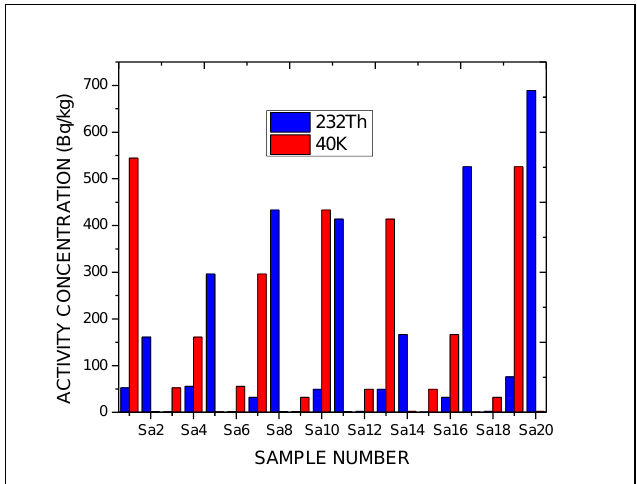
Figure 2: A Comparative Bar Graph Showing Activity Concentration of 232 Th and 40 K in the Collected